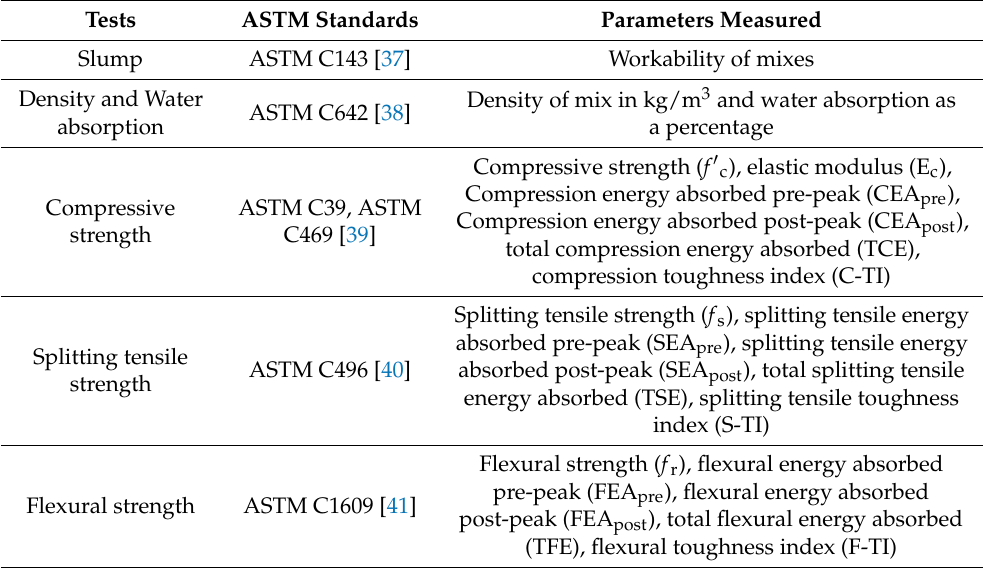
Table 5. Tests conducted and parameters measured in this study.